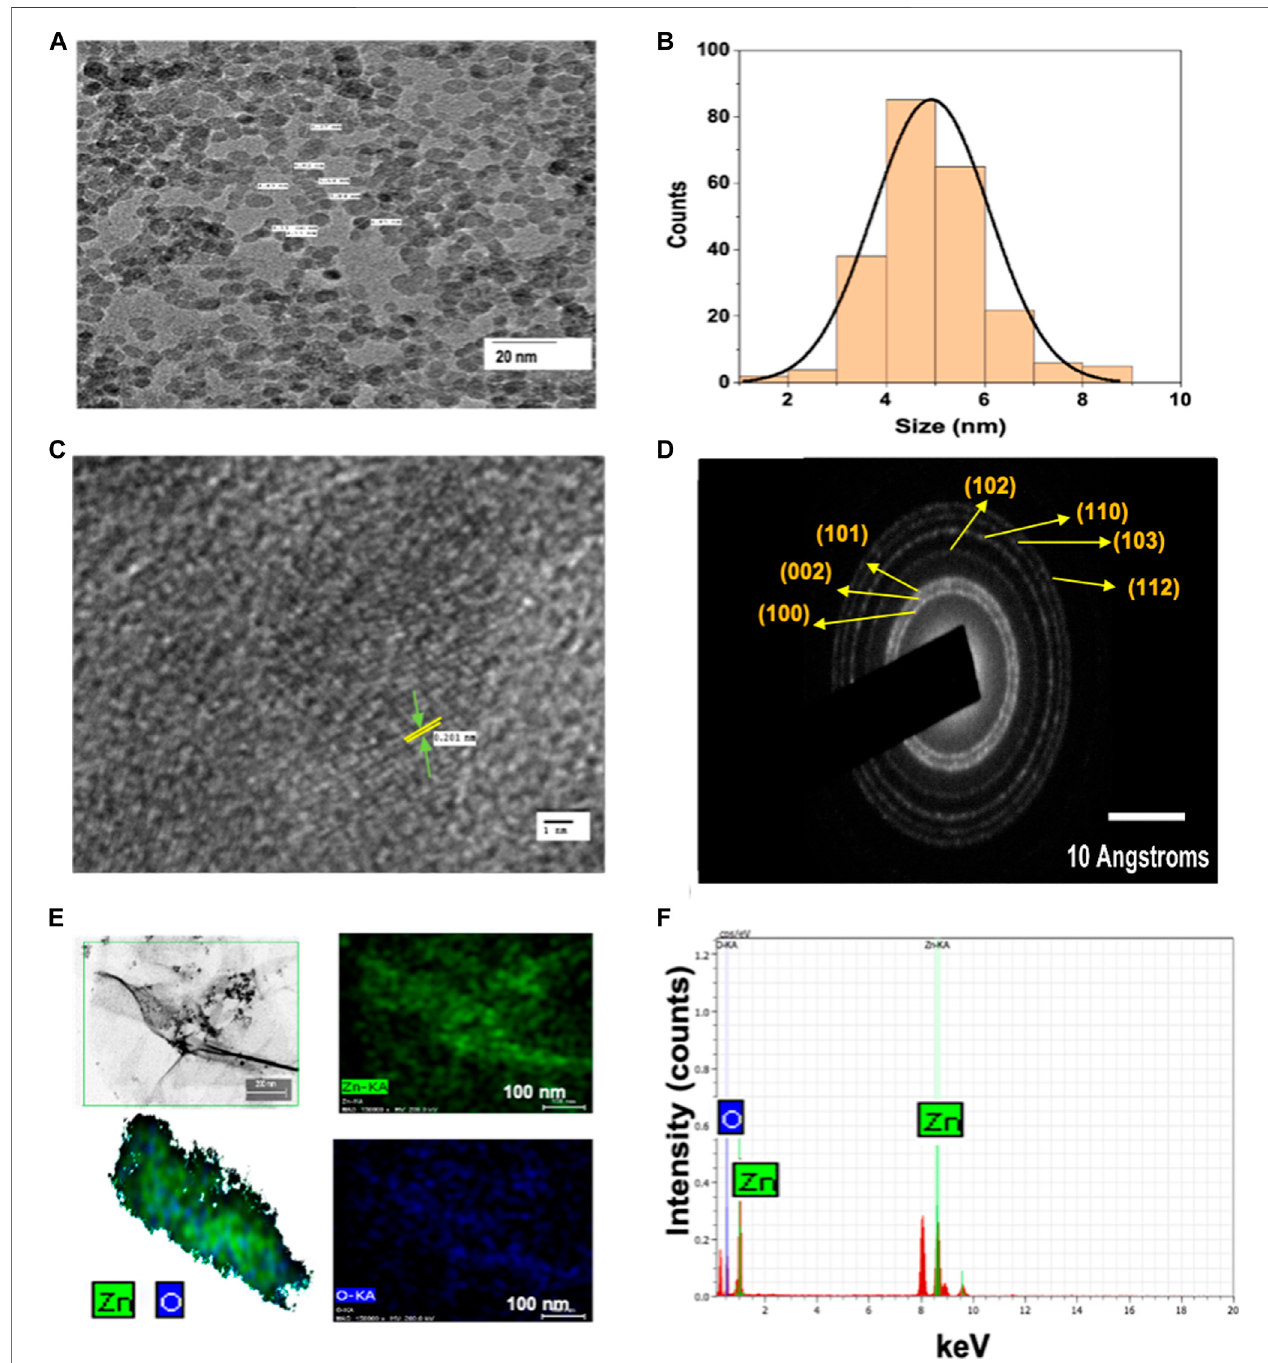
FIGURE 2 | (A) TEM image showing spherical ZnO QDs; (B) histogram depicting mean size (4 – 6 nm) of ZnO QDs; (C) high-resolution TEM image of ZnO QDs, where lattice spacing d (cid:1) 0.201 nm (d represents the distance between two lattice fringes); (D) selected area electron diffraction (SAED) pattern of ZnO QDs; (E) TEM- EDX mapping of ZnO QDs; (F) TEM-EDX spectra of ZnO QDs with strong peaks at 0.5, 1.0, and 8.6 keV.